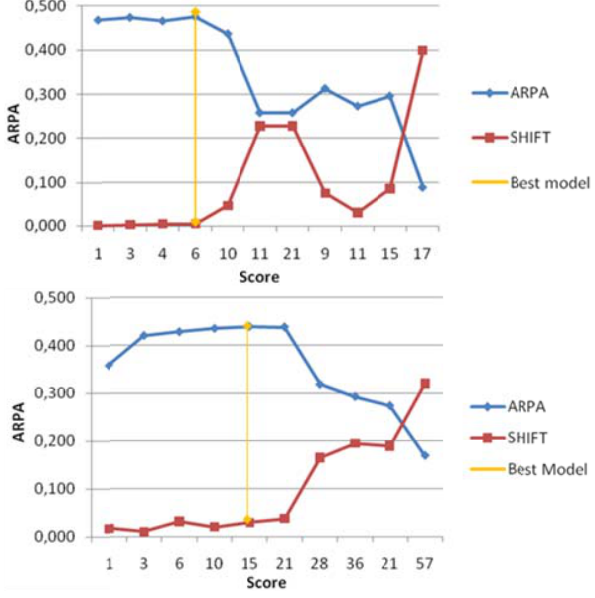
Fig. 5. Correlation between ARPA and SHIFT morphometric in- dexes for suite models; Falls (a) ; Debris flows (b)